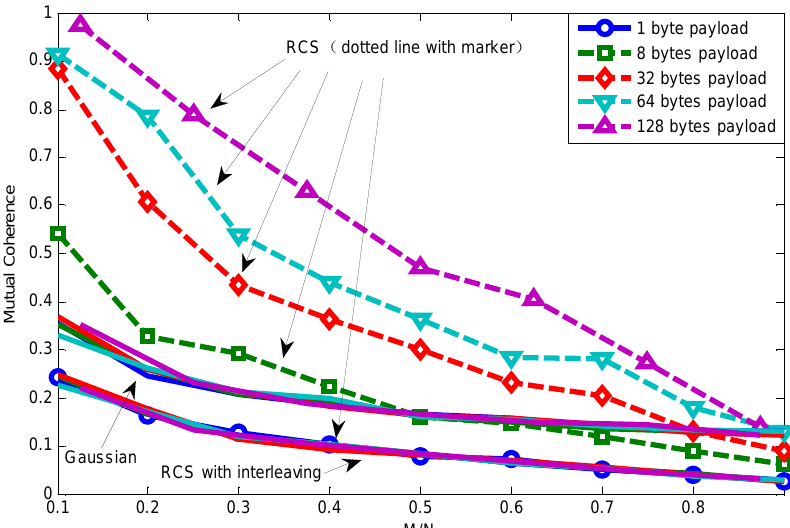
Figure 10. Relationship between mutual coherence and packet length using RCS projection with interleaving.